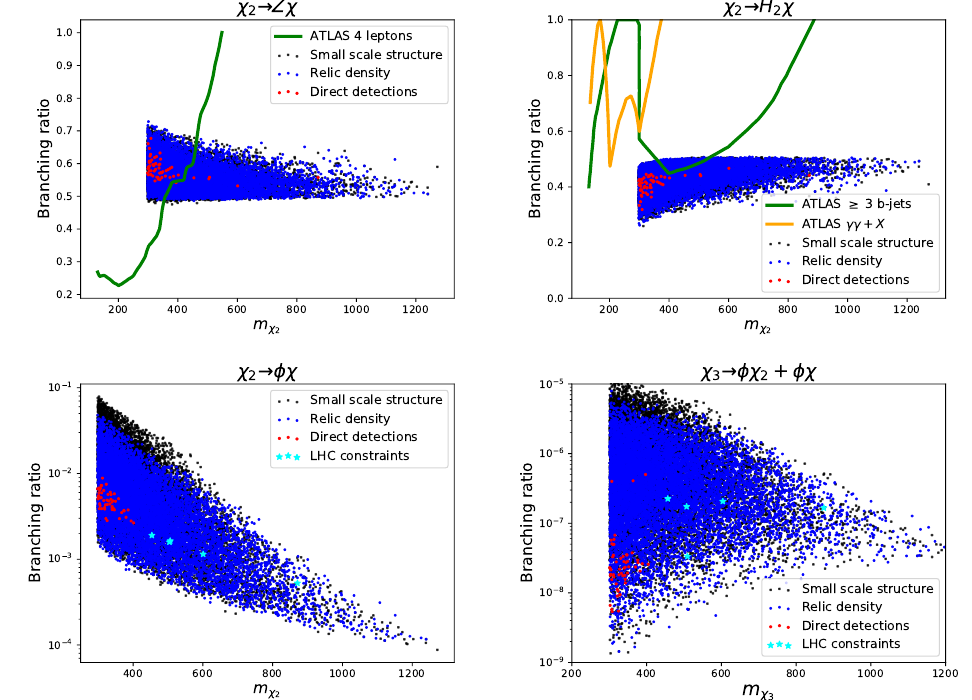
Figure 6 . Decay branching ratios of the neutral Higgsinos ( χ 2 and χ 3 ). Points pass different constraints are indicated in the same way as in figure 4. In the upper panels, the LHC search constraints [52–54] on the Higgsino decaying into Z boson and Higgs boson are imposed. In the lower panel, the points that also evade the LHC search constraints are marked in green. In the lower right panel, the summed branching ratios of χ and χ are 3 → φχ 3 → φχ 2